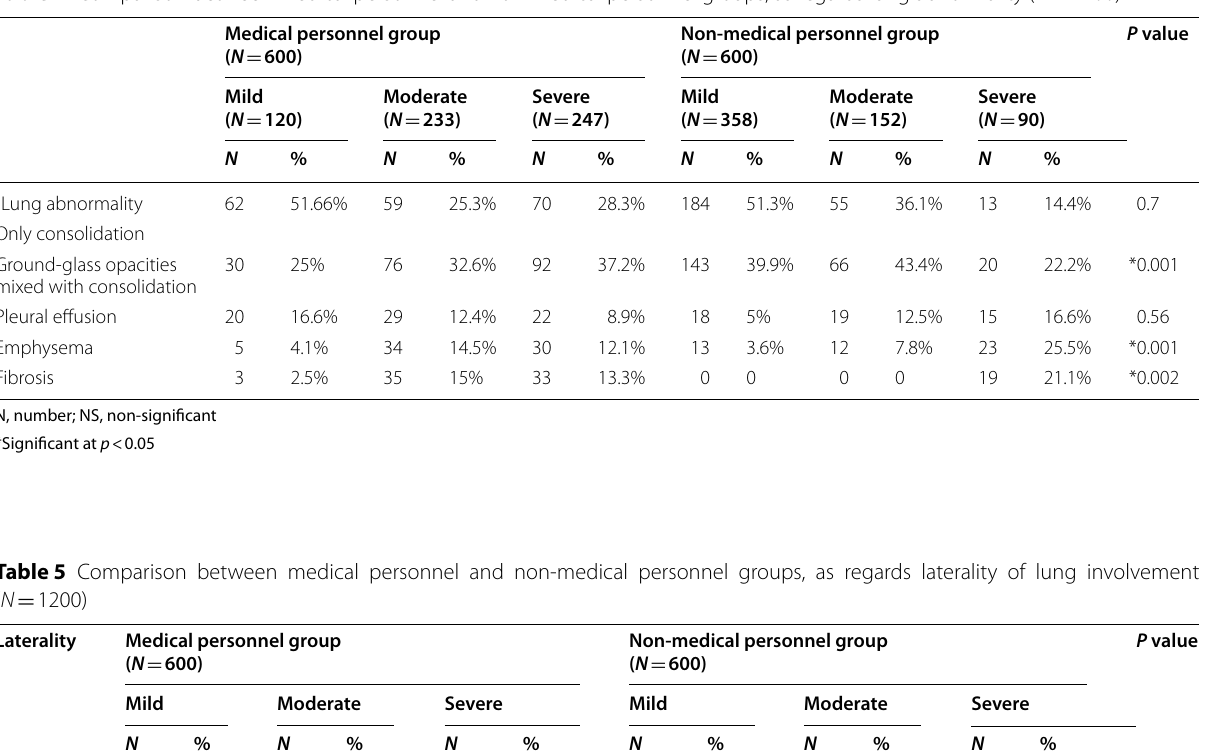
Table 4 Comparison between medical personnel and non-medical personnel groups, as regards lung abnormality ( N